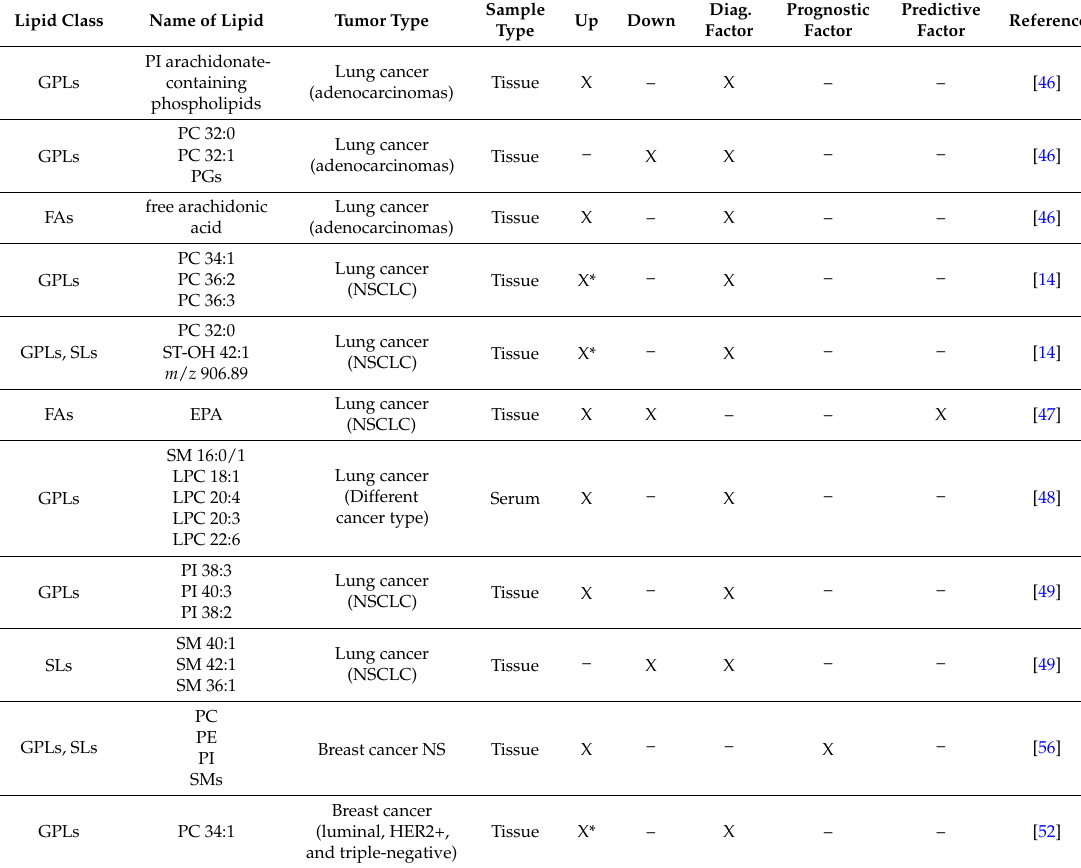
Table 2. The table lists the main lipids studied in this review in various tumor types, specifying with a symbol “X” if these have been found to be up or down-regulated in the respective sample type, as well as if they have diagnostic, prognostic or therapy response predictive value X*: an analysis of spatial distribution was performed; X ◦ : lipids have predictive value of therapy response in case of patients receiving neoadjuvant chemotherapy; X§: study reveals a specific cut-off of the lipids with a diagnostic power; NS = Tumor type not specified. Ref: References; GPLs: Glycerophospholipids; FAs: Fatty Acids; SLs: